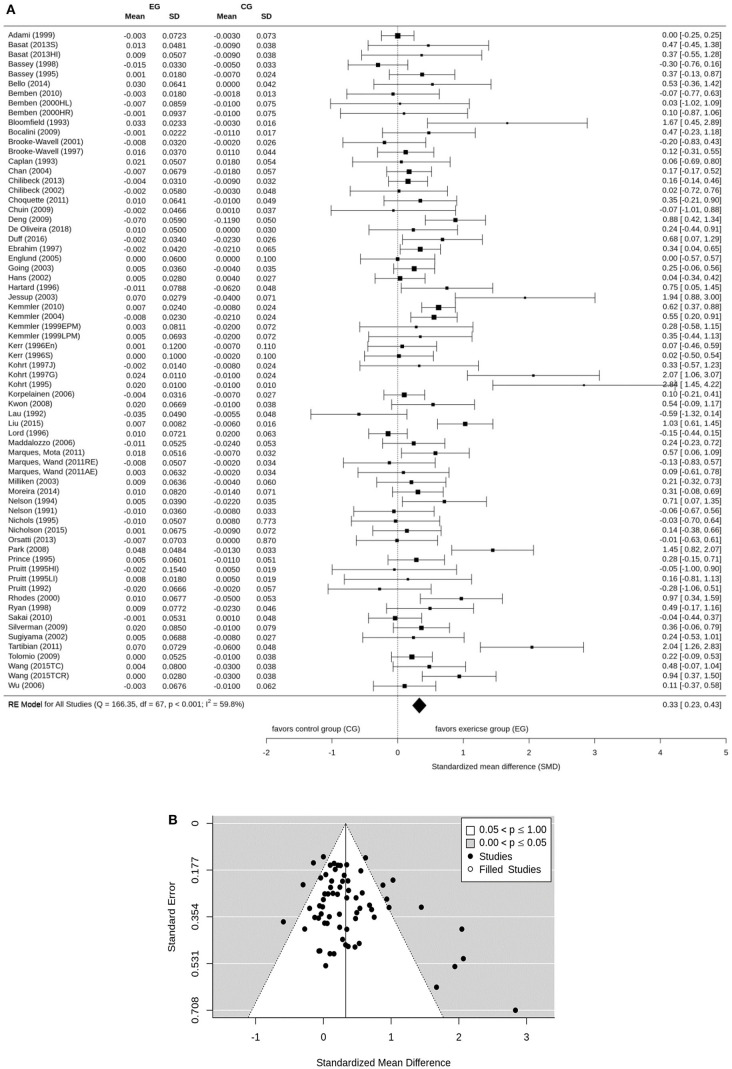
(A) Forest plot of meta-analysis results at the FN. The data are shown as pooled standard mean difference (SMD) with 95% CI for changes in exercise and control groups. (B) Funnel plot of FN BMD with Trim and Fill. SE, standard error of standardized mean diffterence; SMD, standardized mean difference.